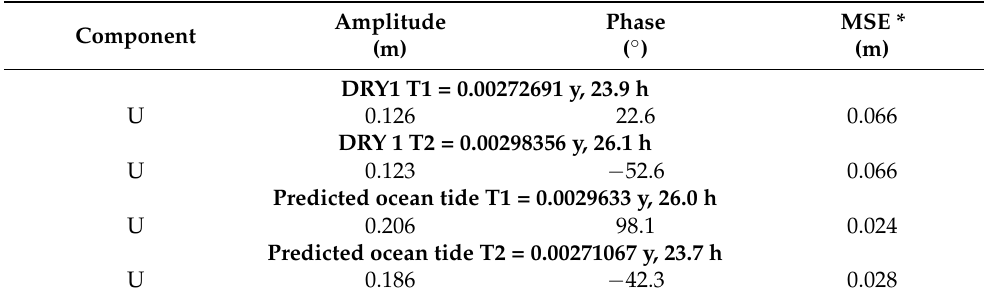
Figure 6. Lomb–Scargle periodograms computed for DRY1 ( A , top ) and ICF1 ( B ) GNSS time series, separately for each coordinate component. Figure ( A , bottom ) shows a zoom of the region near the peak (1 × 10 − 3 y = 8.76 h) of the DRY1 analysis. Figure ( C ) shows the same analysis of the Up component of the predicted ocean tide at Mario Zucchelli Station (MZS) obtained by harmonic coefficients available in the ATG database. The ordinates show Lomb-Scargle Power, the abscissa the period (0.01 y = 3.65 days). Table 2. Estimated most significant parameters coming from the spectral analysis of the DRY1 and predicted ocean tide time